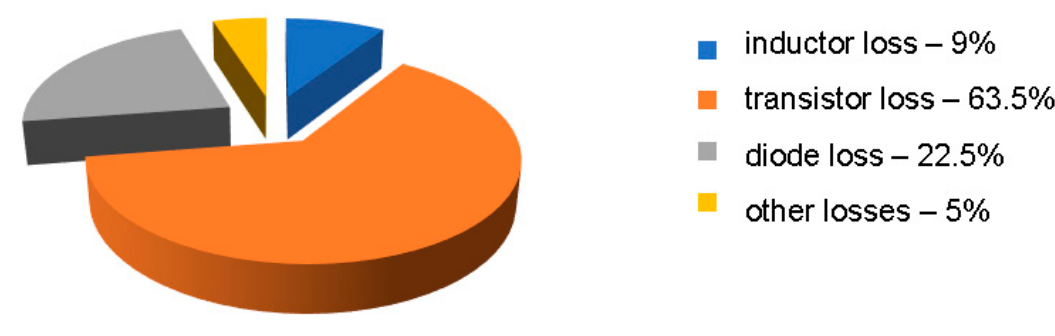
Figure 20. Power loss distribution of the proposed converter at highest efficiency 96.2%.